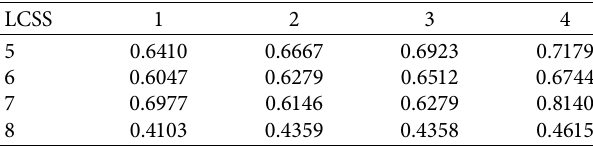
Table 5: Comparison of the lane change trajectory between skilled drivers and NGSIM drivers.